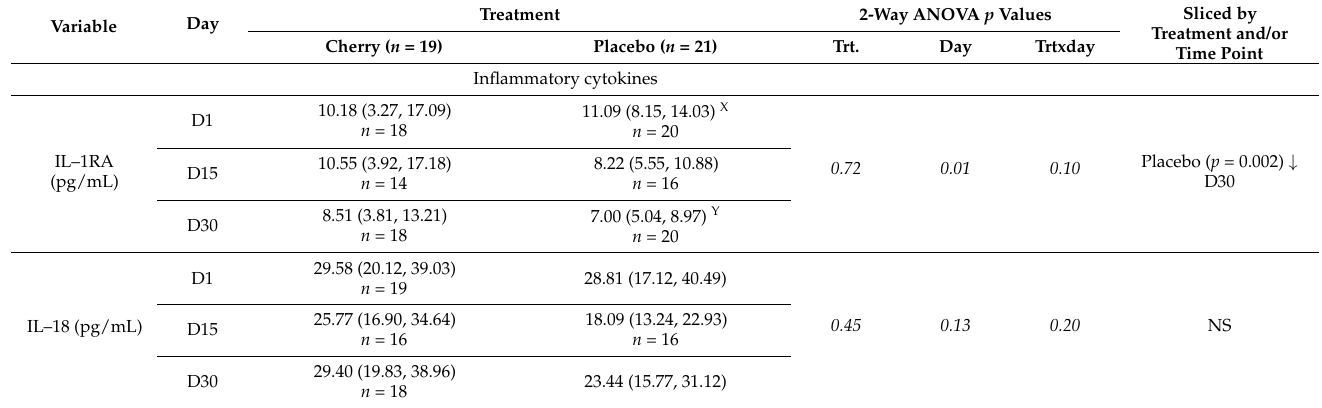
Table 2. Biomarkers of inflammation and oxidative